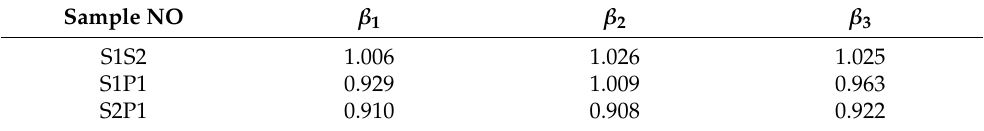
Table 5. Composite effect coefficient of recycled aggregate concrete after composite